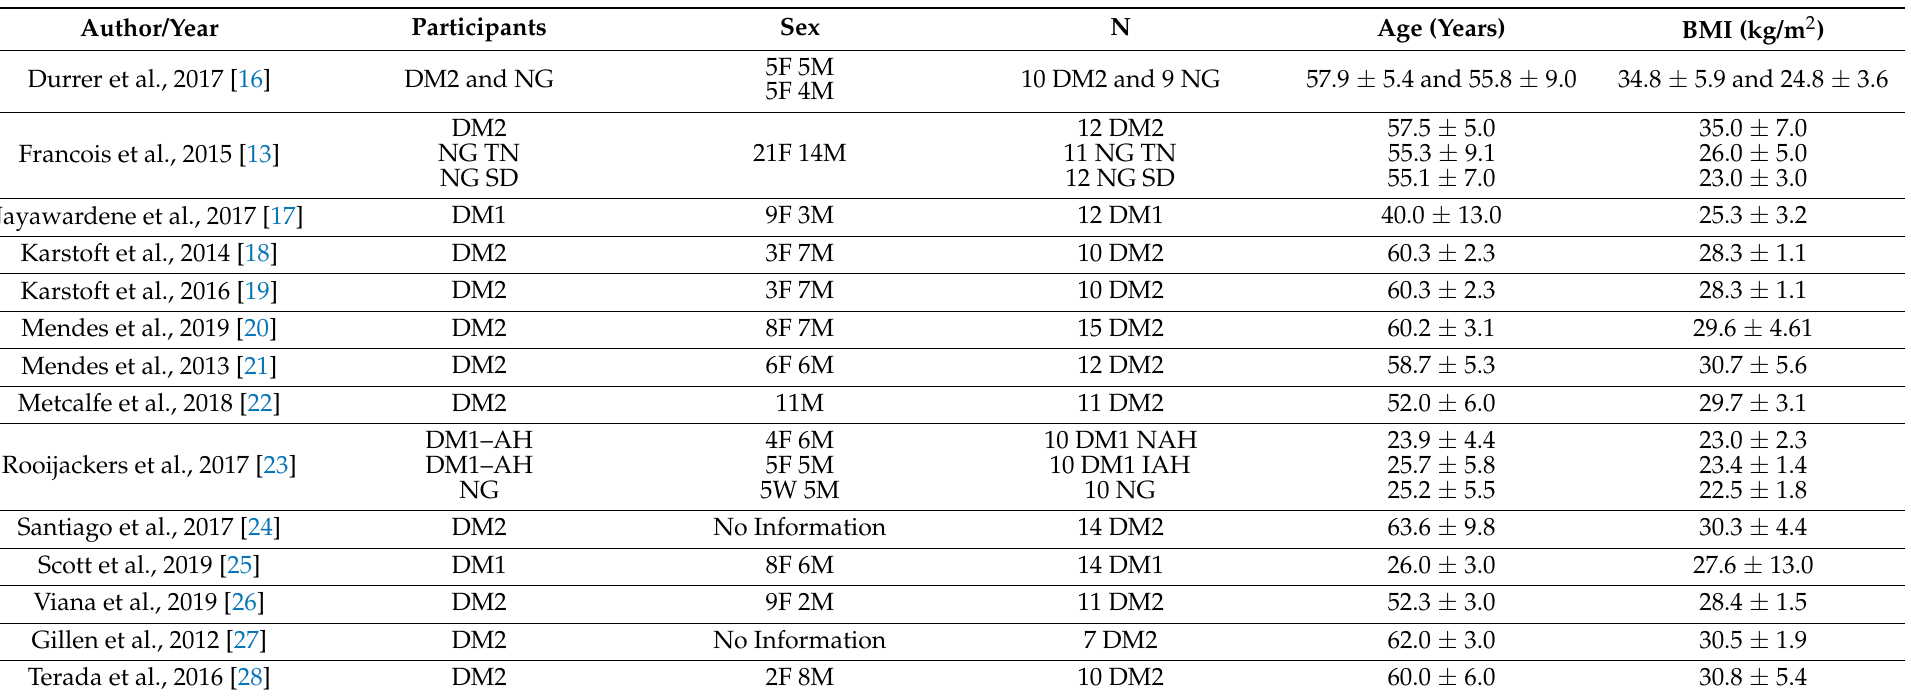
Table 2. Characteristics of the participants in the